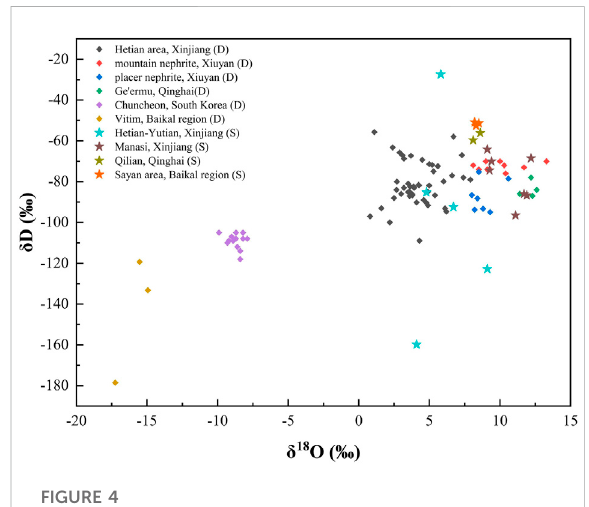
FIGURE 4 Hydrogen and oxygen isotopic values of D-type and S-type nephrite from Xinjiang, Liaoning and Qinghai in China, Chuncheon, South Korea and Baikal region ( ◆ stands for D-type nephrite; + stands for S-type nephrite.).